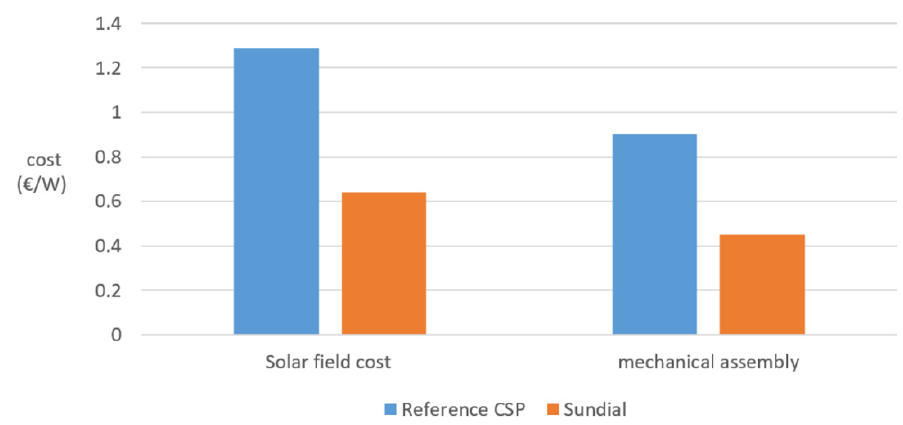
Figure 23. Solar field and mechanical assembly construction cost comparison.